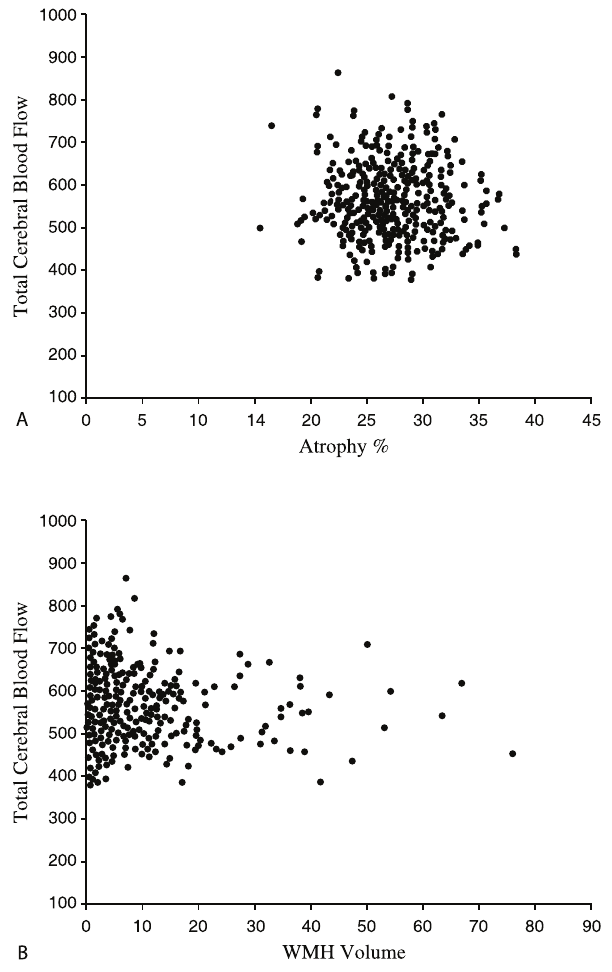
Figure 4. Association of tCBF (in mL/min) with atrophy and WMH volume. Scatterplot of tCBF (mL/sec) versus atrophy (%) ( r =–.077; p =.103) ( a ) and total WMH volume (mL) ( r =–.069; p =.148) ( b ). Atrophy was defined by the following equation: intracranial volume